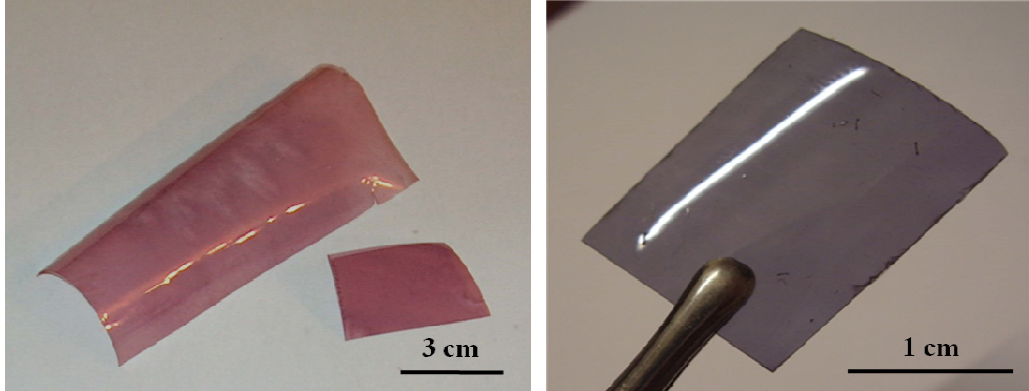
Figure 1. Polystyrene films dyed by the surface plasmon resonance of gold nanoparticles. Depending on the average cluster size, films of different colors can be achieved (ruby-red, purple, and